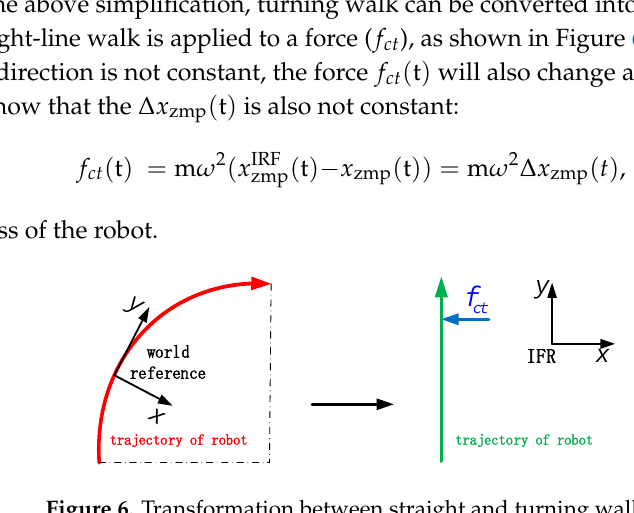
Figure 6. Transformation between straight and turning